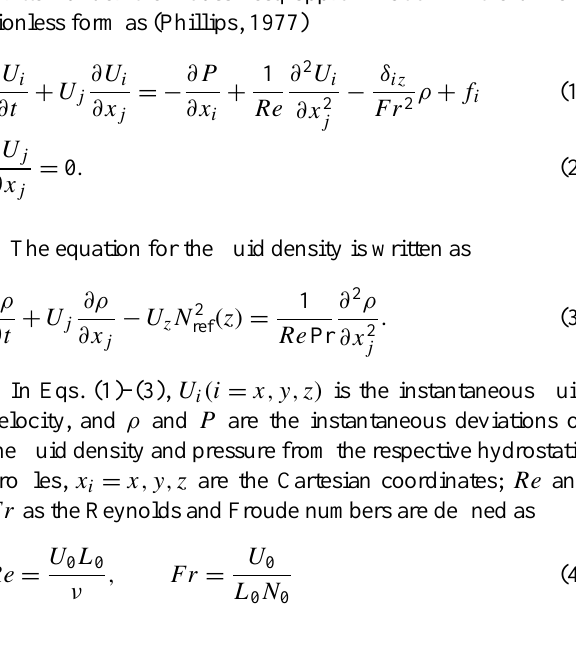
Fig. 1. Schematic of the numerical experiment: x,y,z are the Carte- sian coordinates; ρ 0 is the density above the pycnocline; 1ρ 0 the density jump across the pycnocline; g the gravity acceleration, N m 0 the buoyancy frequency in the pycnocline center; L 0 the pycnocline thickness; z p and z f the locations of the pycnocline center and the forced turbulence layer center, respectively.